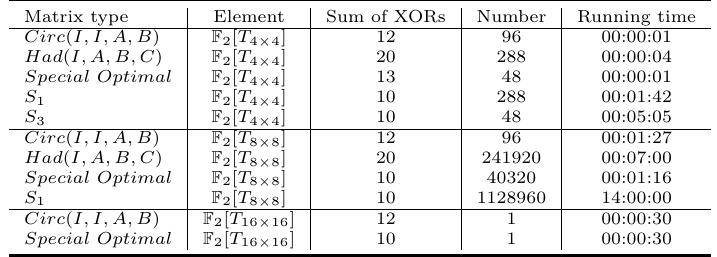
Table 3: Number of lightweight MDS matrices and running time Matrix